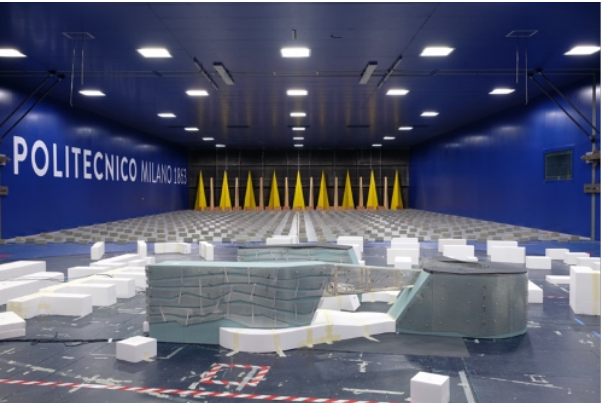
Figure 3. Wind tunnel tests on 1:75 scaled model of the ENI Head Office buildings.